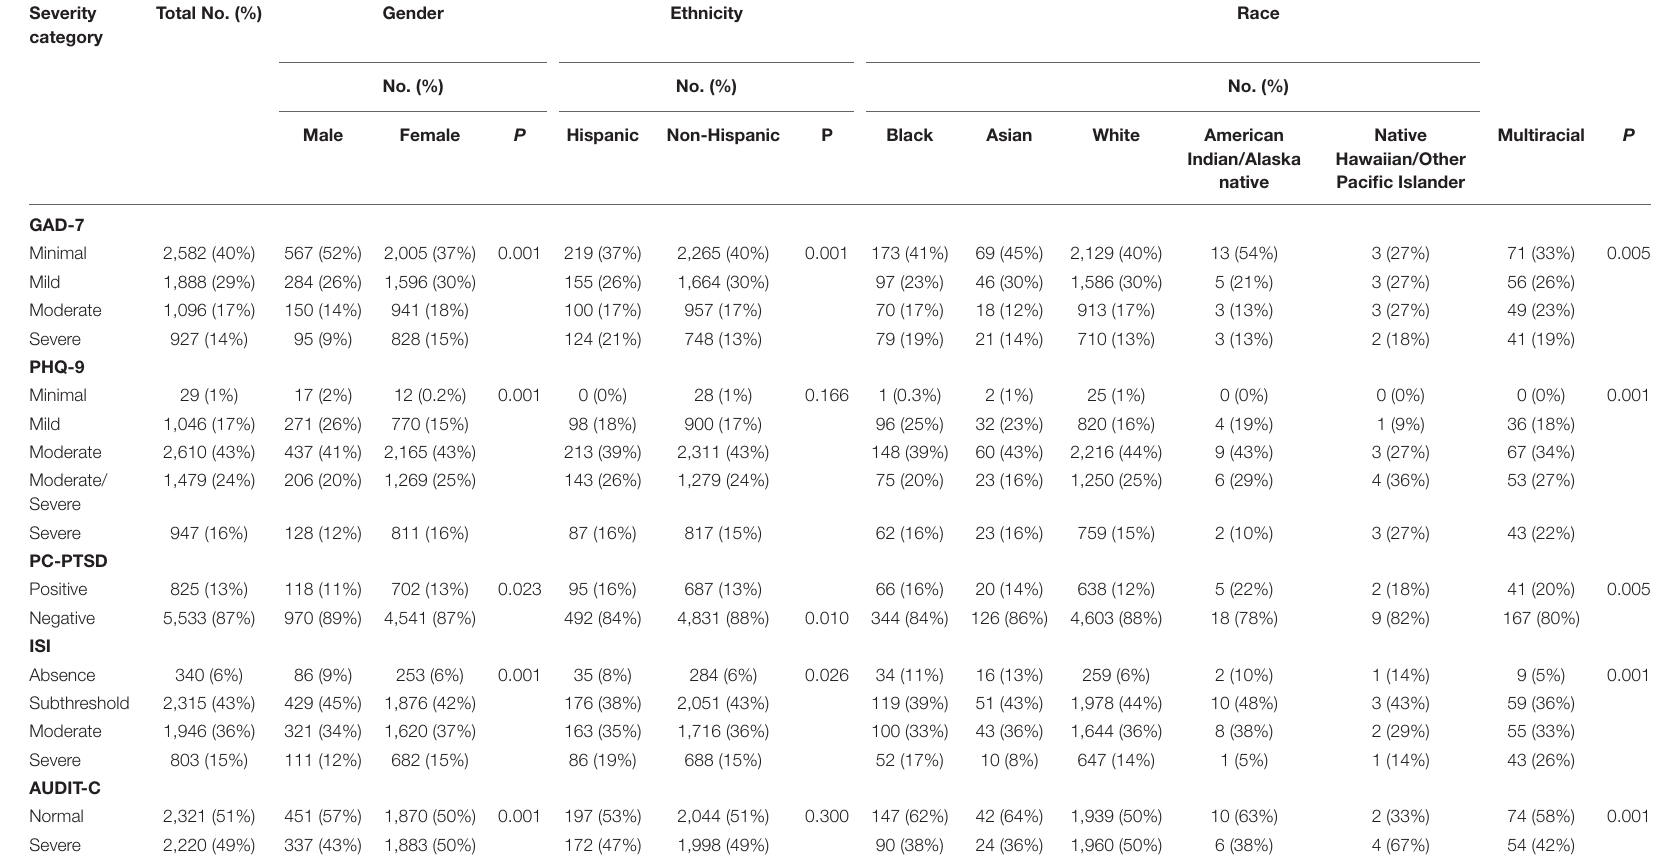
TABLE 2 | Rates of depression, anxiety, post-traumatic stress disorder (PTSD), and insomnia by demographics. Severity